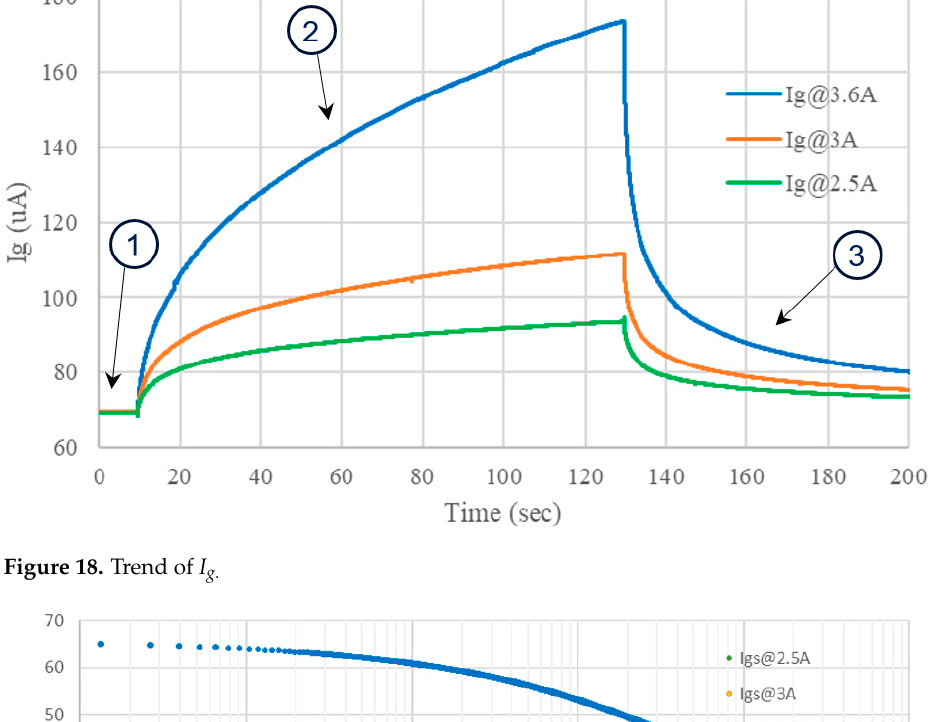
Figure 17. Measurement electrical circuit for I g. The result of some measurements is shown in Figure 18.